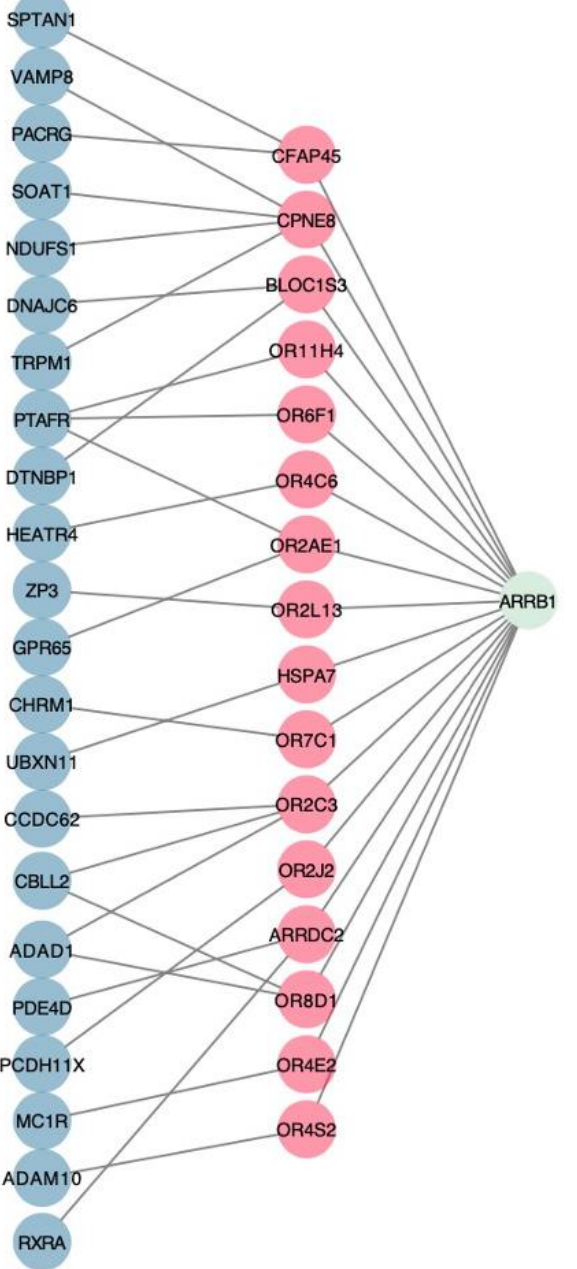
Figure 4. The network of common driver genes that are associated with olfactory transduction and GPCR. Red nodes correspond to the common drivers and blue nodes and green nodes correspond to dementia genes and OSA genes, respectively. This represents the fundamental premise behind identifying common gene drivers common to both disease processes.